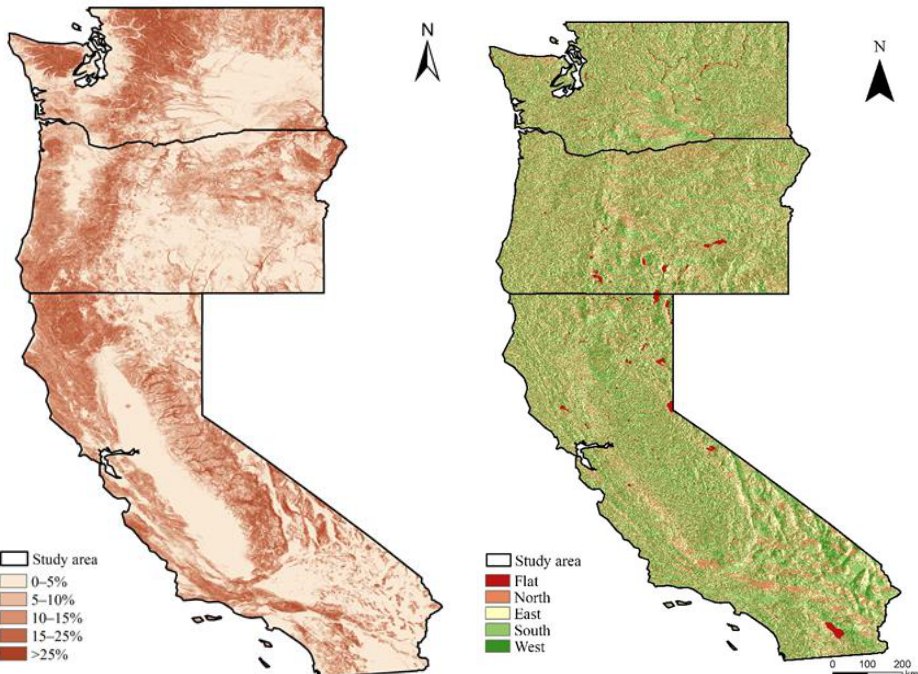
Figure 5. Maps of the slope ( left ) and aspect ( right ) in the study area.